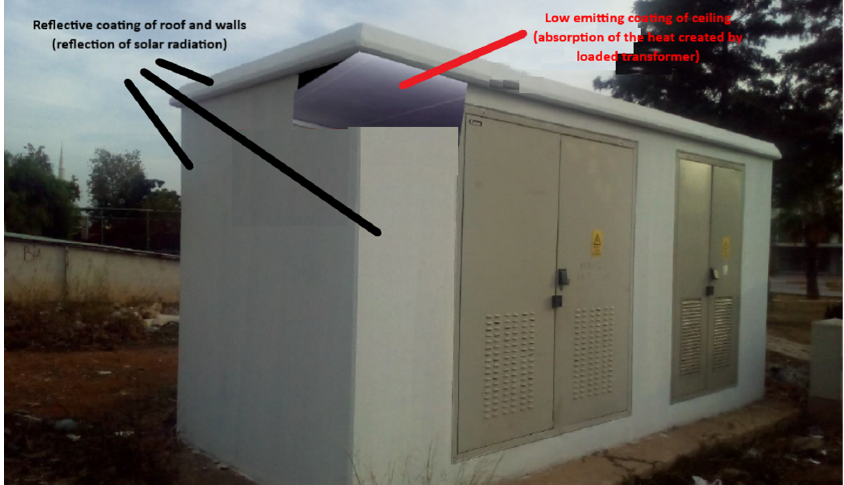
Figure 1. Sample transformer building with the reflective and low-emitting coating.